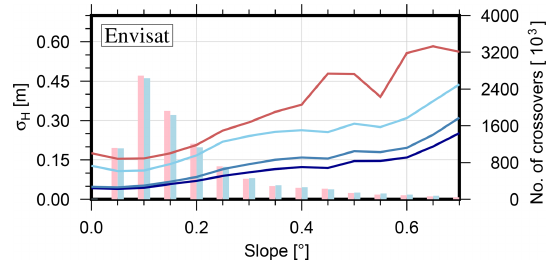
Figure 2. Precision of different processing versions of Envisat mea- surements from near-time ( < 31 days) crossovers, binned against slope. Red curve: ESA version with ICE-2 retracker and relocated by mean surface slope. Light, medium and dark blue curves: data reprocessed in this study with 50%-, 20%- and 10%-threshold re- tracker, relocated using the refined method. Vertical bars: number of crossovers for the ESA (red) and our 10% threshold retracked data (blue). Table 1. Noise level and slope-related component ( s in degrees) of the measurement precision, fitted to near-time crossovers (unit: m) of the data from the respective data center and our reprocessed data (with a 10% threshold retracker